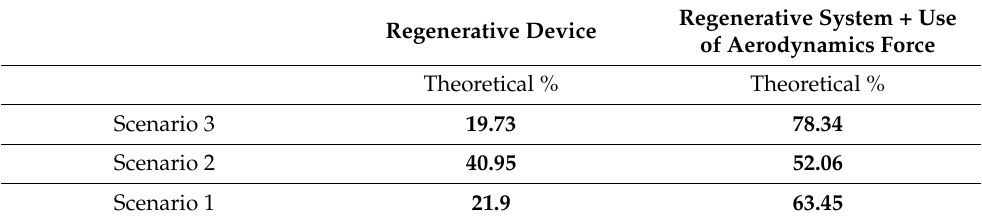
Table 7. Theoretical percentage of power than can be